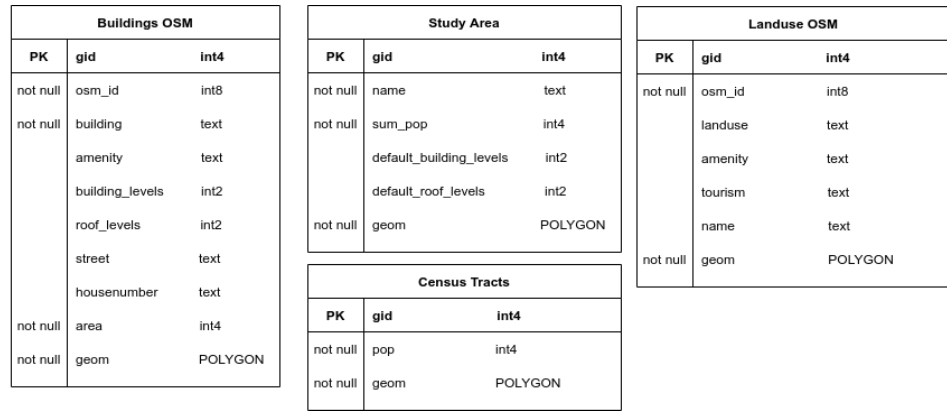
Figure 5. Required input